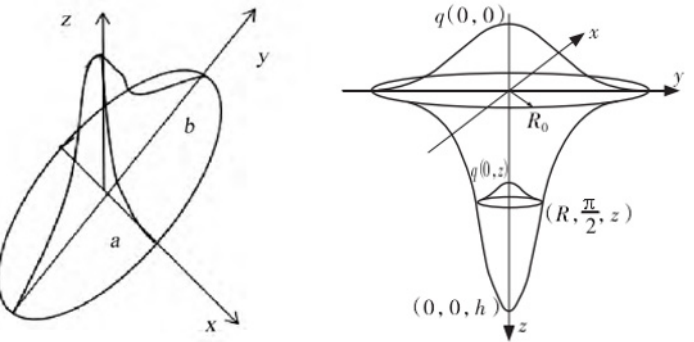
Figure 11. The 2D elliptic heat source model [36] and 3D Gauss heat source model of revolution [37].